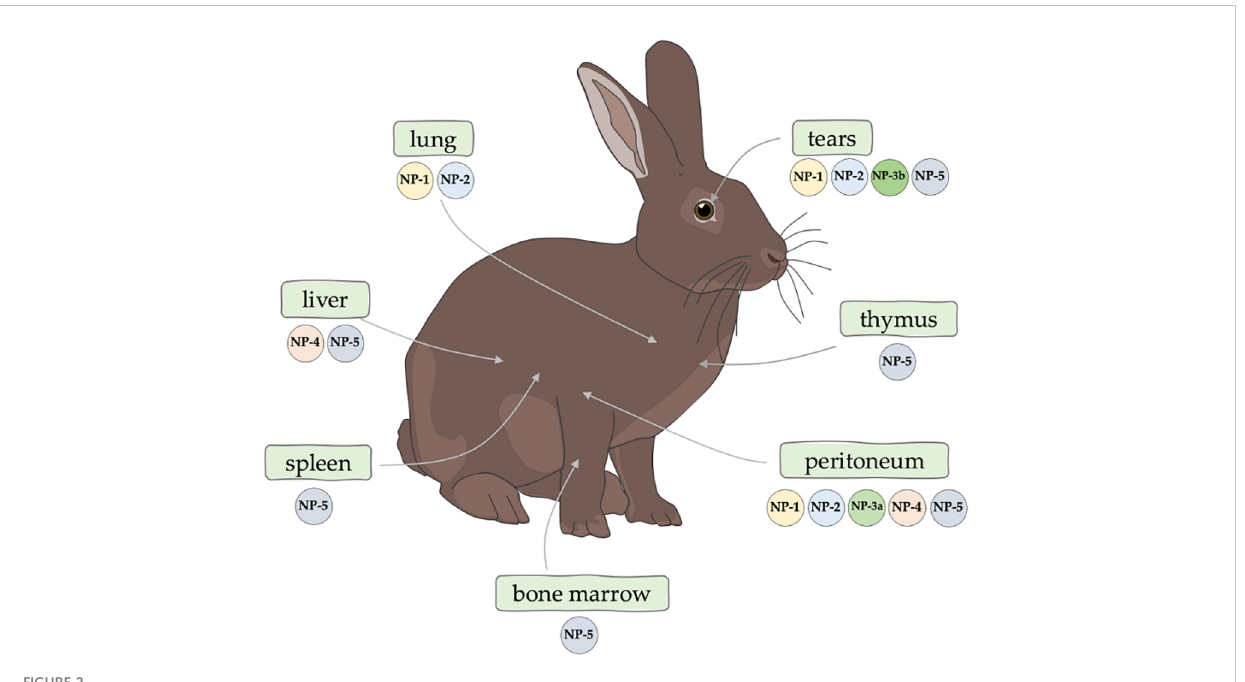
FIGURE 2 Con fi rmed occurrence of rabbit a